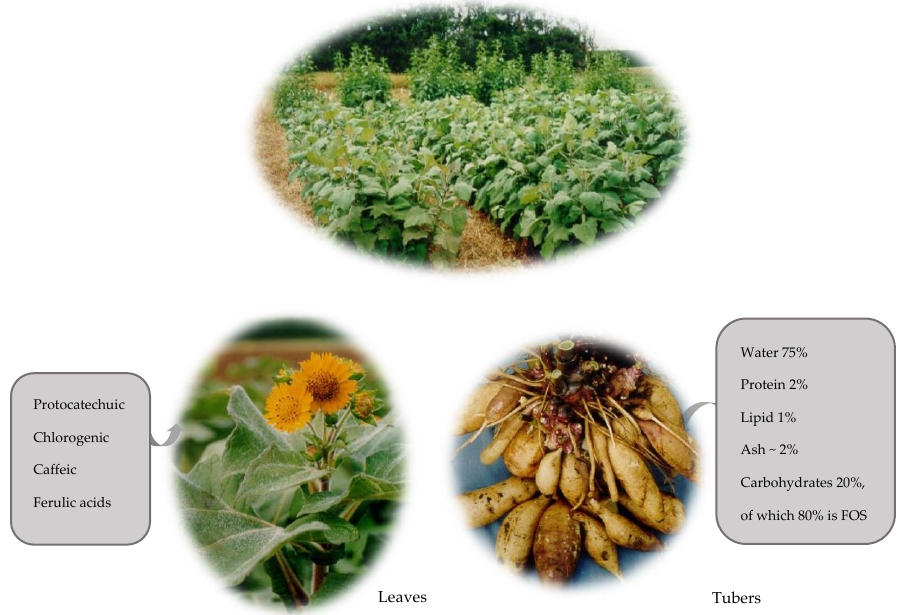
Figure 1. Yacon plants grown in New Zealand, annotated with nutritional and chemical composition of yacon leaf and tuber (photos: Crop and Food Research New Zealand).